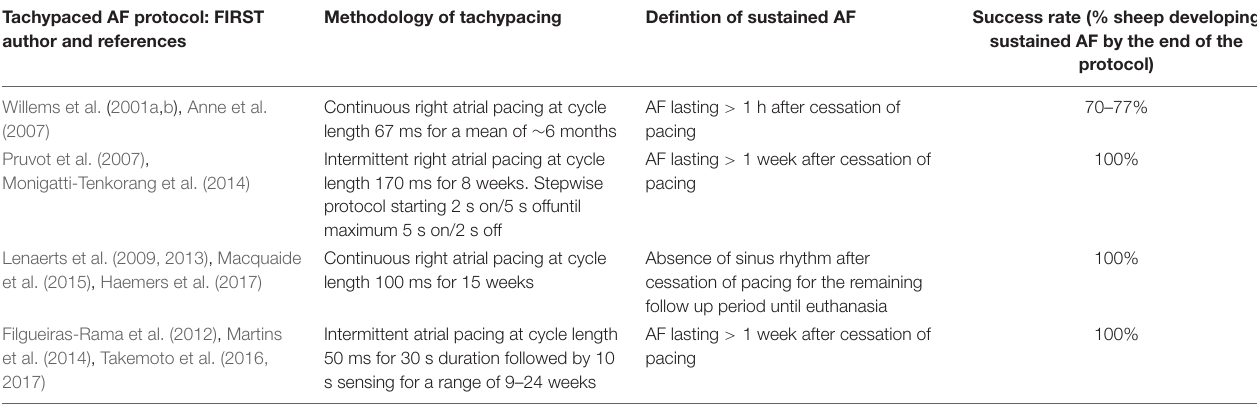
TABLE 3 | A summary of studies in the literature utilising a tachypacing methodology to induce sustained atrial fibrillation in